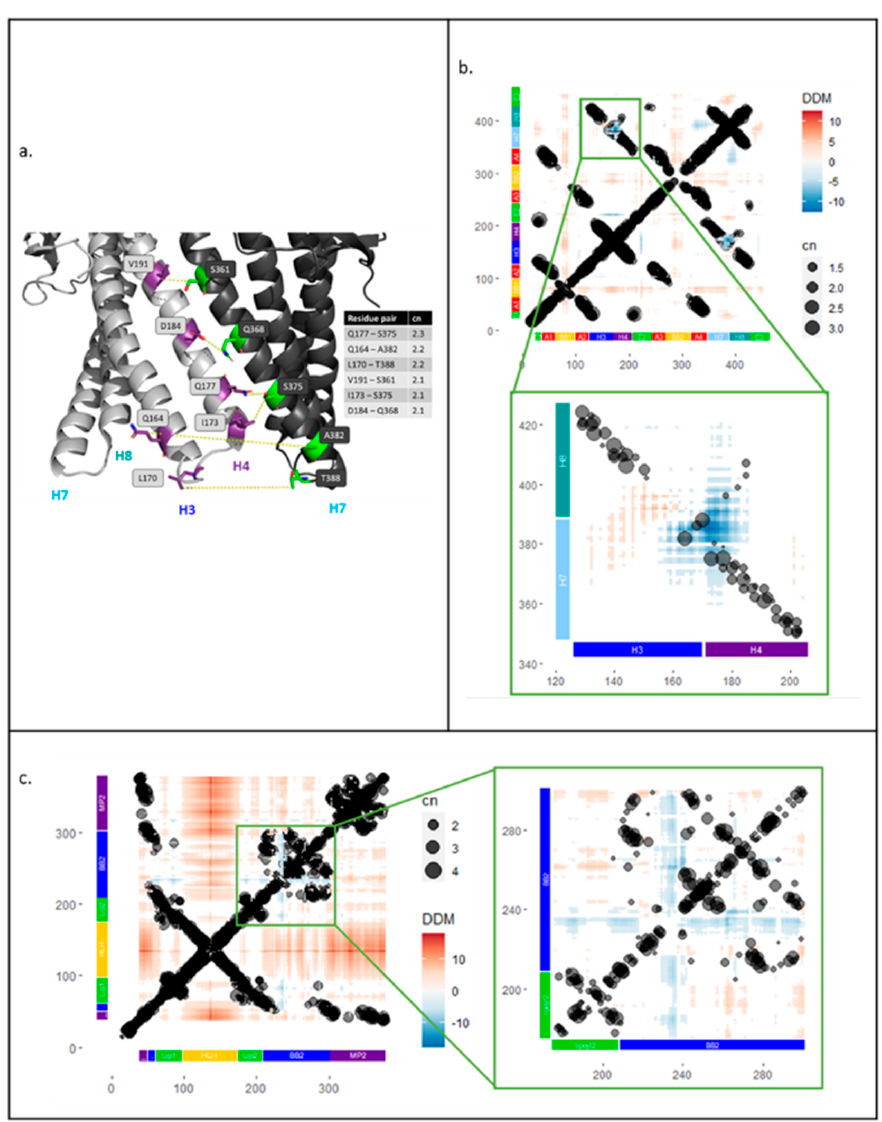
Figure 3. Strongly coupled residues at the interface between TolC subunits. Residue pairs in TolC identified from screen of evolutionary couplings data were filtered for couplings with cn ≥ 2 between residues in H3 and H4 (126–206) and residues in H7 and H8 (348–427) helices. ( a ) The cartoon shows helices of two TolC subunits in the transport-active open state with residue pairs between H3 and H4 helices of one protomer (light grey) and H7 helix of the second protomer (dark grey) (5NG5). Overlay of evolutionary couplings onto difference distance matrix analysis for TolC and AcrA. ( b ) Main: Difference distance matrix (DDM) and evolutionary couplings (EC) overlay for TolC protomer with domain structure on both axes. Inset: DDM and EC overlay for TolC periplasmic helices H3, H4, H7, H8. ( c ) Main: DDM and EC overlay for one AcrA subunit with domain structure on both axes. Inset: DDM and EC overlay for lipoyl and BB domains of